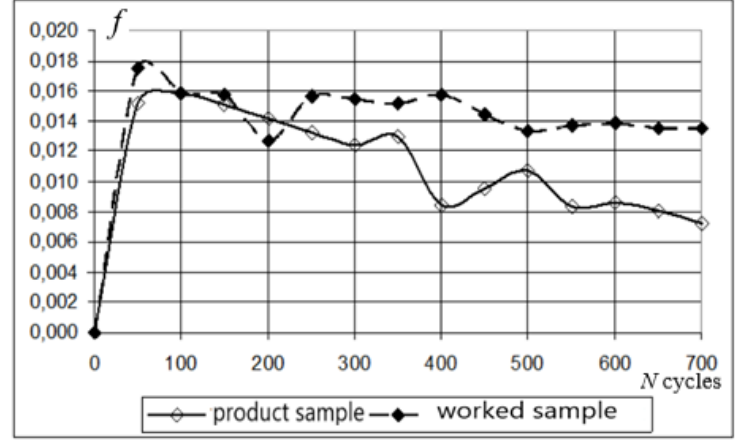
Fig. 3. Dependence of friction coefficient on working life at volumetric temperature of oils 20 0